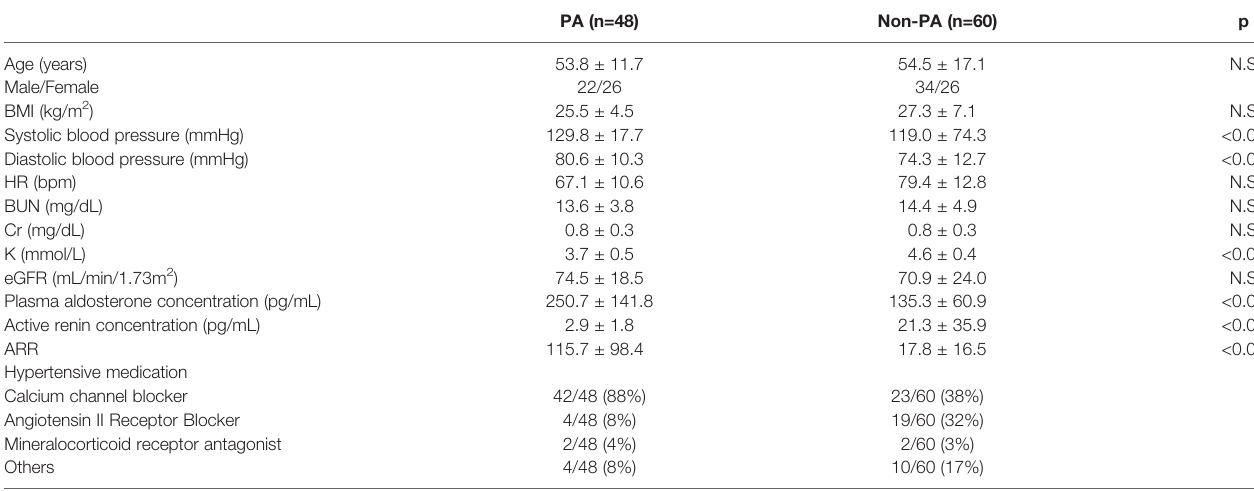
TABLE 1 | Baseline Clinical